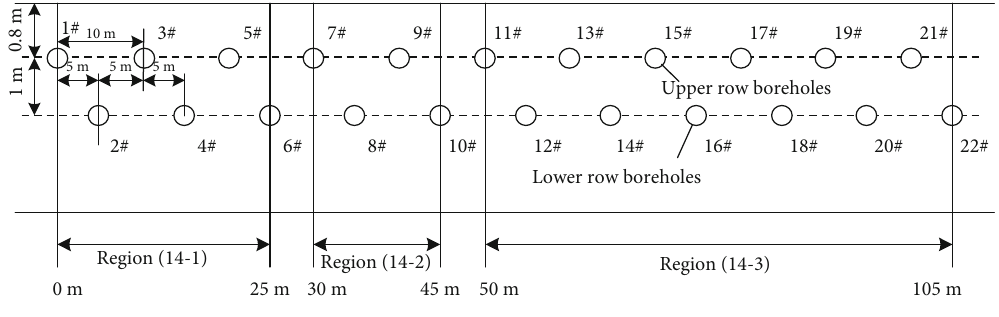
Figure 10: Layout of the boreholes. Table 3: Parameters of the boreholes.